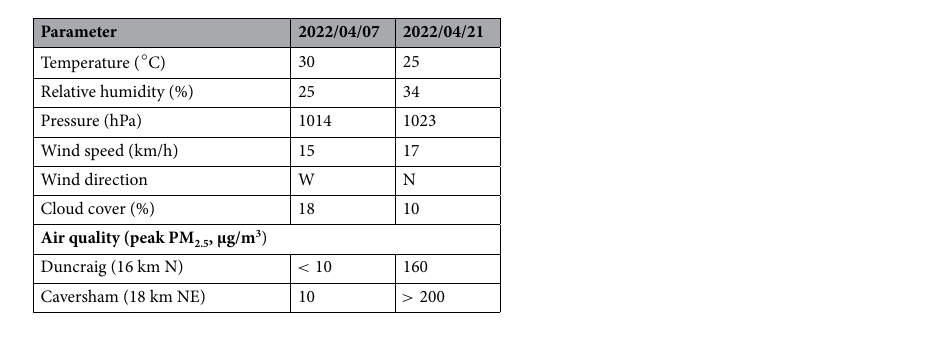
Table 3. Atmospheric conditions in Perth for flight